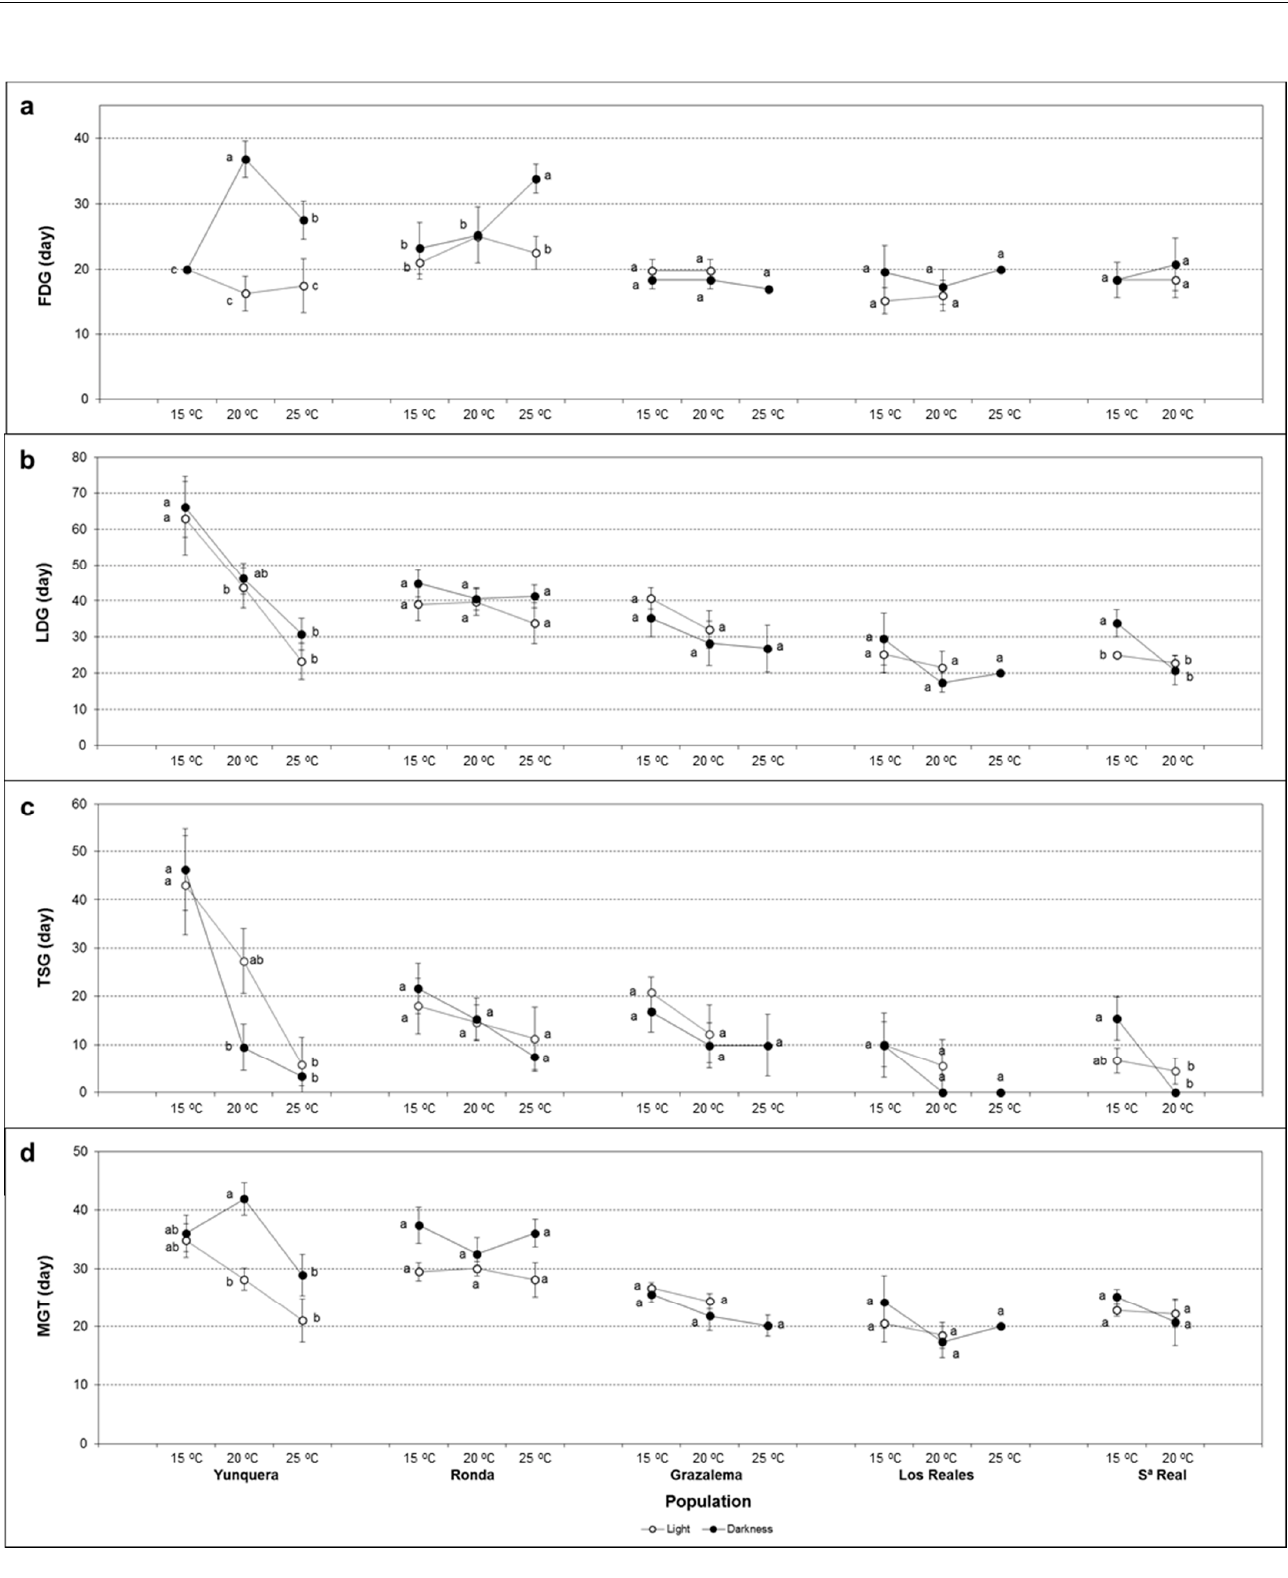
Figure 2. Effect of temperature and light on germination parameters of A. pinsapo seeds from different provenances: ( a ) FDG; ( b ) LDG; ( c ) TSG; and ( d ) MGT. Data represent the mean ± SEM. Different letters within each population indicate significant differences by the LSD test with a significance level of 0.05.